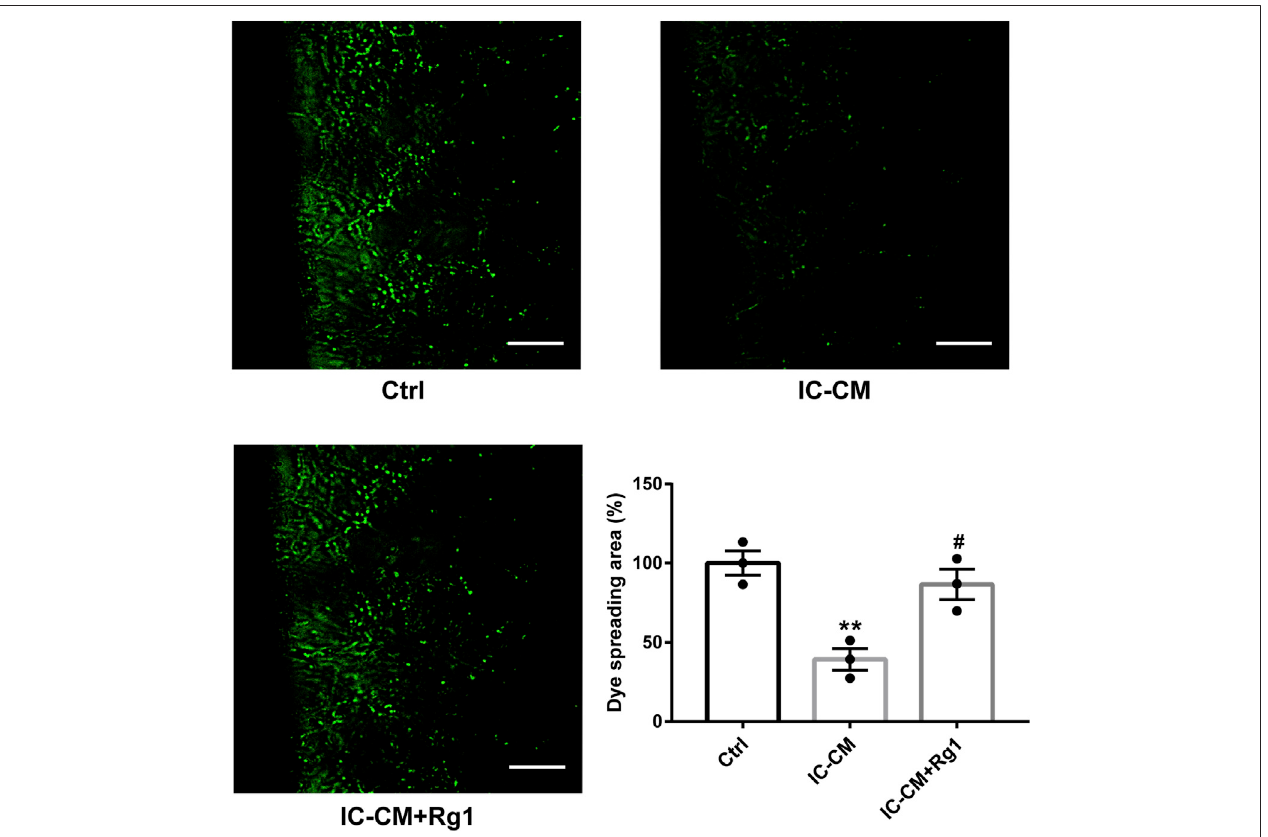
FIGURE 7 | Rg1 ameliorates in fl ammation-induced gap junctional dysfunction in glial cells. The SLDT assay was conducted to detect the in fl uence of Rg1 or in fl ammatory cytokines on gap junction intercellular communication, which was indicated by the dye spreading area. Scale bar (cid:1) 100 μ m. n (cid:1) 3. ** p < 0.01, compared with the Ctrl group; # p < 0.05, compared with the IC-CM group. SLDT, scrape-loading and dye transfer; IC-CM, in fl ammatory cytokines-conditioned medium.